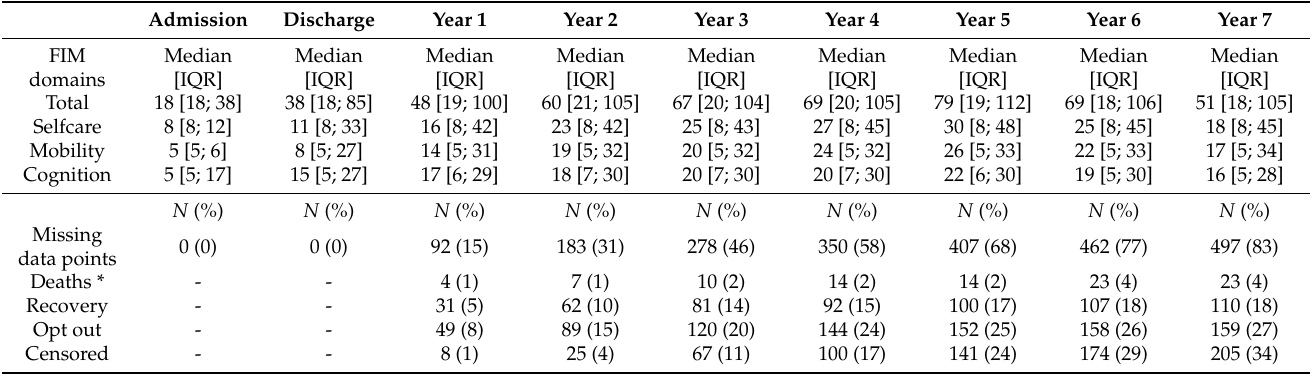
* Deaths were computed for the patients enrolled in the study and admitted to the post-acute rehabilitation center. Thus, they do not include patients who died during intensive care, before potential referral. FIM is Functional Independence Measure; IQR is interquartile range